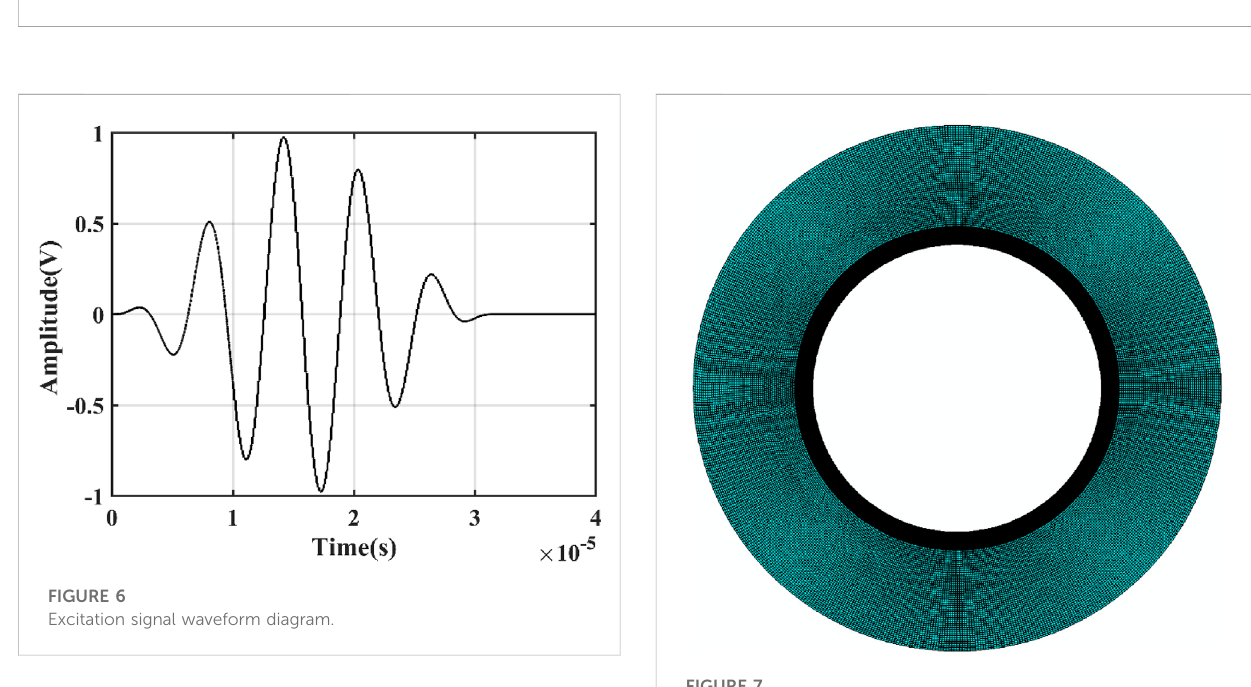
FIGURE 7 Meshing of cementing casing